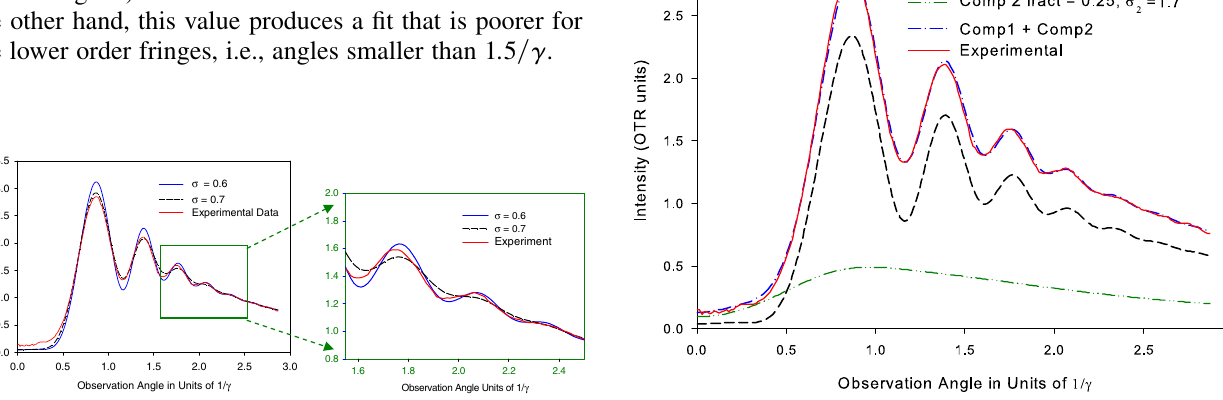
FIG. 11. (Color) Comparison of effect of convolution of two weighted Gaussians with different fractional amplitudes and rms widths on OTRI fringes.